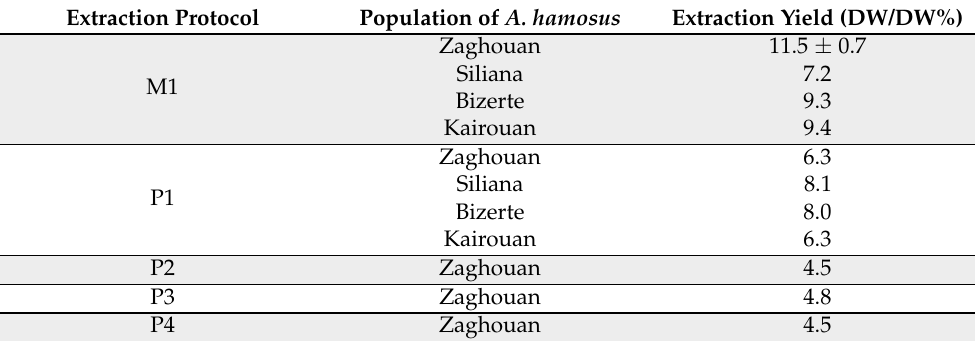
Table 1. Results of extraction yields (DW/DW) for Protocols M1 and P1, P2, P3, and P4. Extraction Protocol Population of A.